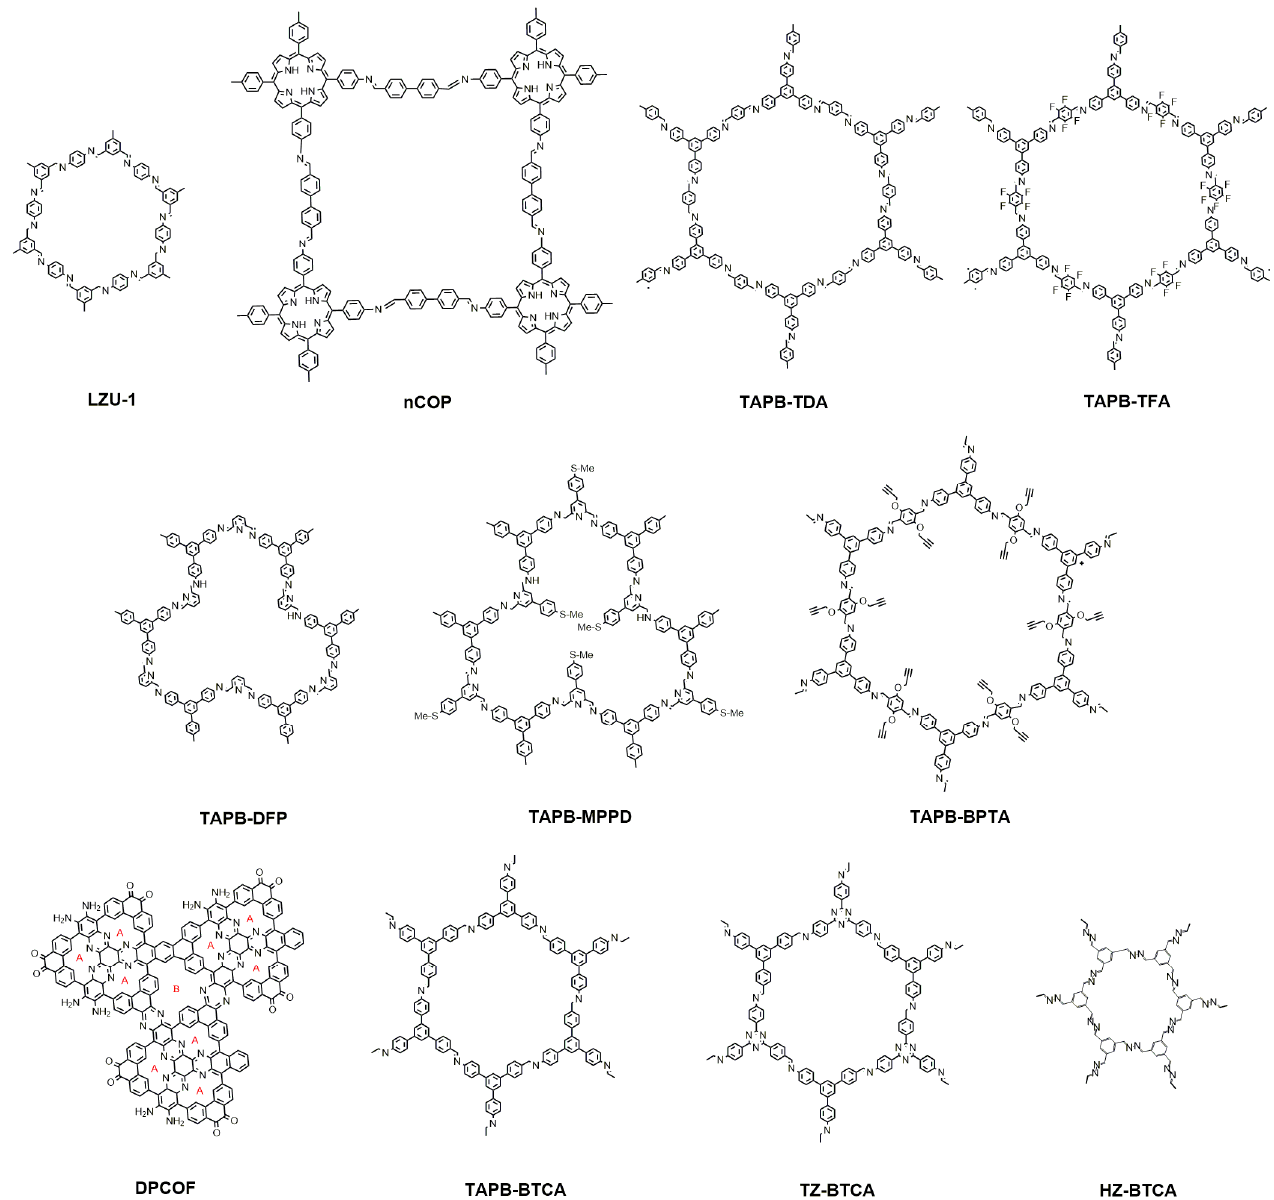
Figure 3. Structure of the imine ‐ and enamine ‐ containing COFs. In 2017, 1,3,5 ‐ Triformylbenzene (TFB), 4 ‐ (tert ‐ butoxycarbonylamino) ‐ aniline (NBPDA), and poly(N ‐ vinylpyrrolidone) (PVP) were dissolved in ethanol and trifluoroa ‐ cetic acid to create COF LZU ‐ 1 with hexagonal structure by the microwave ‐ assisted syn ‐ thesis in only 30 min at a temperature of 120 °C [63]. Guntern et al. developed this proce ‐ dure to prepare colloidal COF/Nanocrystal Hybrids (NC@LZU1) [43]. The particle size was regulated with the addition of PVP as a passivator of the surface and reaction time obtaining particles from 100 to 600 nm. Since LZU1 grows over the NC, the inner layers show a more amorphous character, and the material enhances the crystallinity with the reaction time and particle size increase. Although most of the materials reported are based on Au nanoplates as NC, the authors report that this approach can be applied also to other nanoparticles, such as WO 3 nanowires and Fe 3 O 4 nanospheres. Furthermore, the process can be repeated with subsequent loading of nanocrystals and growth of the COF material to synthesize NC@LZU1@NC@LZU1 core − shell − core − shell structures in the form of col ‐ loidal solutions. The same procedure (NBPDA and TFB in ethanol, PVP, and TFA heated